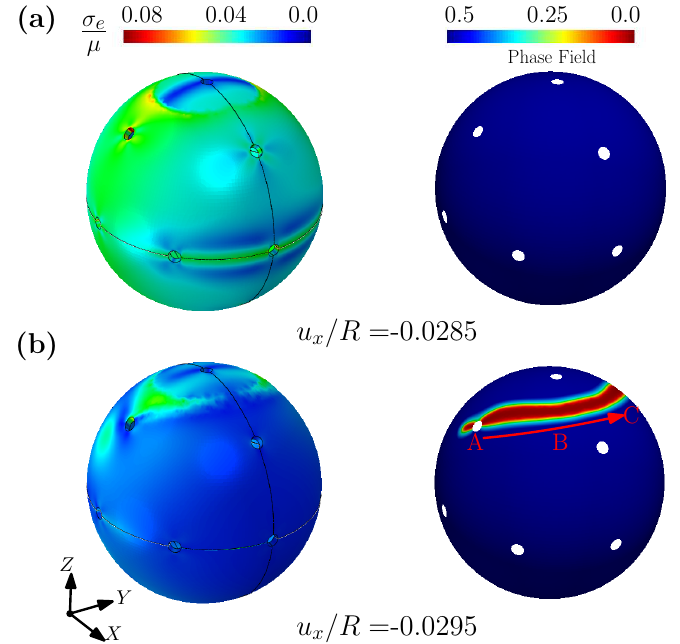
Figure 10. The contour plots of normalized effective Cauchy stress and phase field for spherical shell considering shear, under different displacement u x / R =: ( a ) − 0.0285; ( b ) −